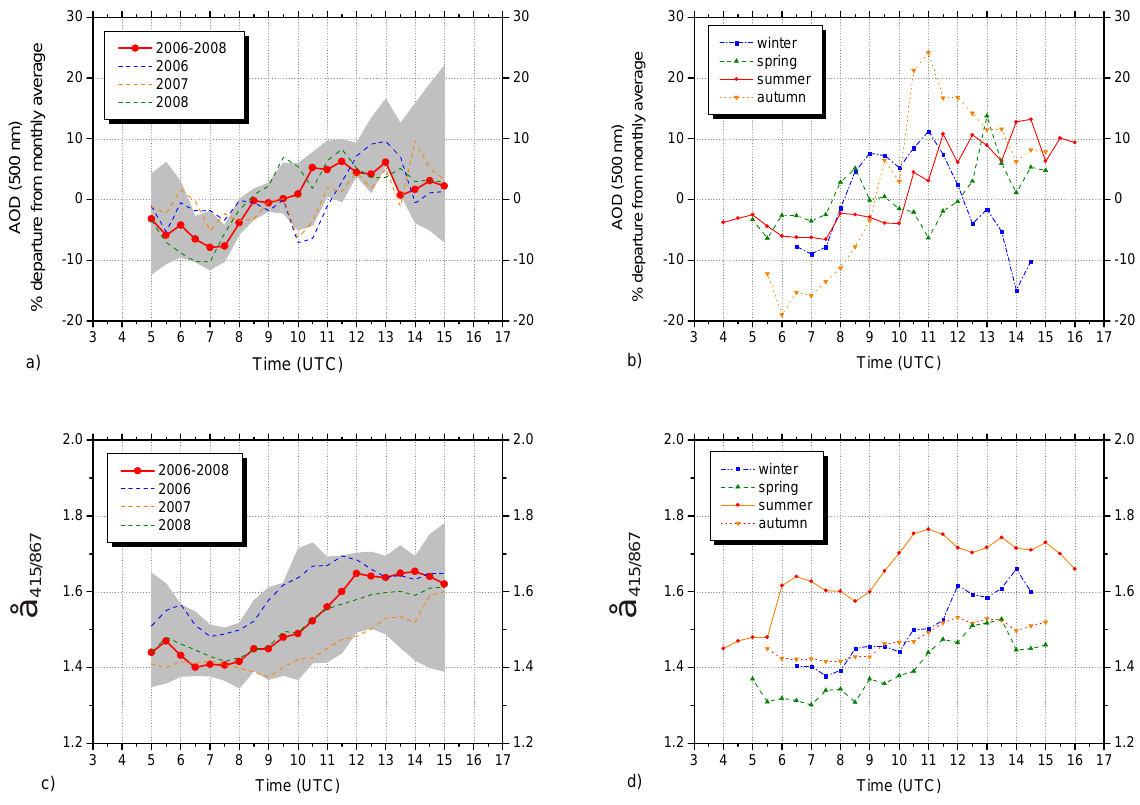
Figure 5. Diurnal variation of AOD at 500 nm and the Ångström coefficient. All values are expressed by medians and for AOD the percentage departure of each half- hour point from the monthly mean is given. In panels (a) and (c) the diurnal cycles are provided on an annual basis for the whole period and separately for each year, while the gray zone represents the inter-quartile range of the monthly median departures at the specific time (for the Ångström coefficient we use absolute values instead of percentage departures). In panels (b) and (d) the diurnal cycles are shown for each season separately.